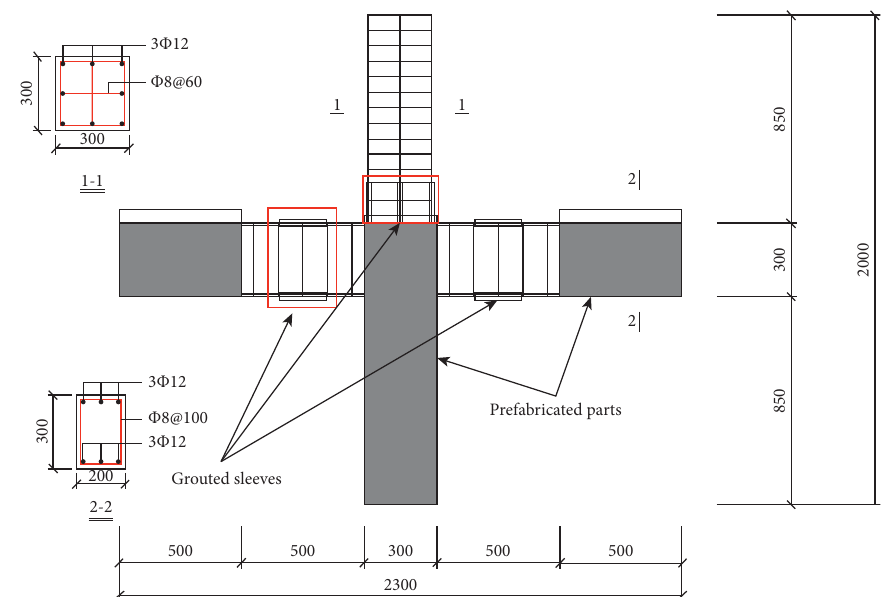
Figure 4: The physical dimension and reinforcement of test pieces (unit: mm).